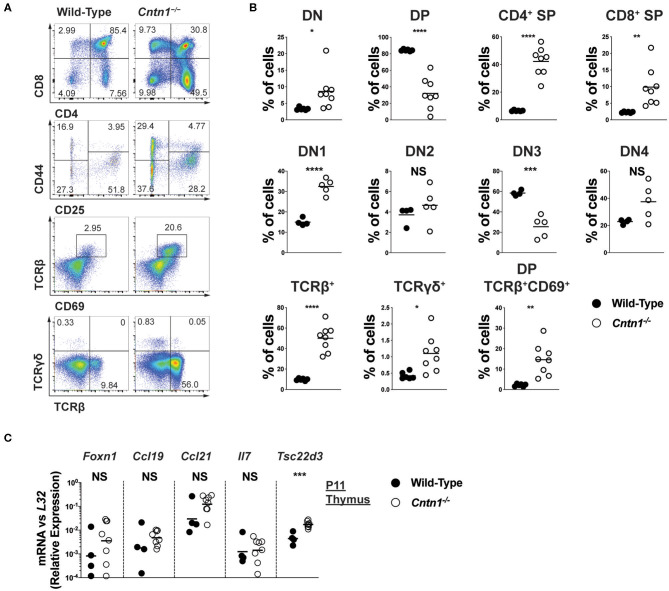
Altered thymocyte development in Cntn1−/− mice is associated with elevated glucocorticoid signaling (A,B). Representative FACS analysis of wild-type (left panels) and Cntn1−/− (right panels) thymuses. Total live thymocytes analyzed for the frequency of DN, DP, and CD4+ and CD8+ SP cells (first row), CD4−CD8− thymocytes analyzed for the frequency of DN subsets using CD25 vs CD44 (second row), CD69 vs. TCRβ in total thymocytes (third row), and TCRβ vs. TCRγδ in total thymocytes (fourth row) (A). The frequency of thymocyte populations from individual wild-type and Cntn1−/− animals are graphed in (B). Analysis of aggregated data by Student's t-test (C). P11 enriched thymic stromal cells from wild-type and Cntn1−/− animals were harvested for RNA and analyzed for the indicated genes by QRT-PCR. Graphs show transcript abundance relative to L32. Individual transcripts were compared by Student's t-test. NS, not significant; *p < 0.05; **p < 0.01, ***p < 0.001; ****p < 0.0001.